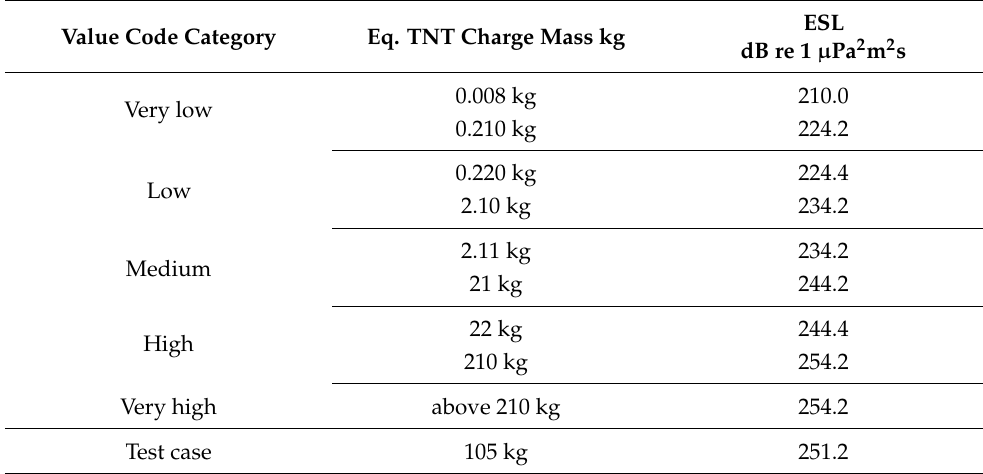
Table 6. Source description according to TG Noise Guidance for the classification of explosion noise with data from